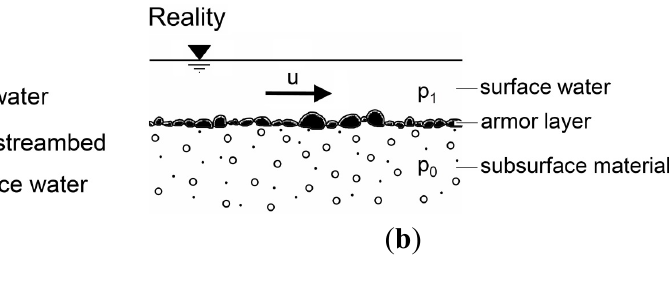
Figure 4. Model ( a ) vs. reality ( b